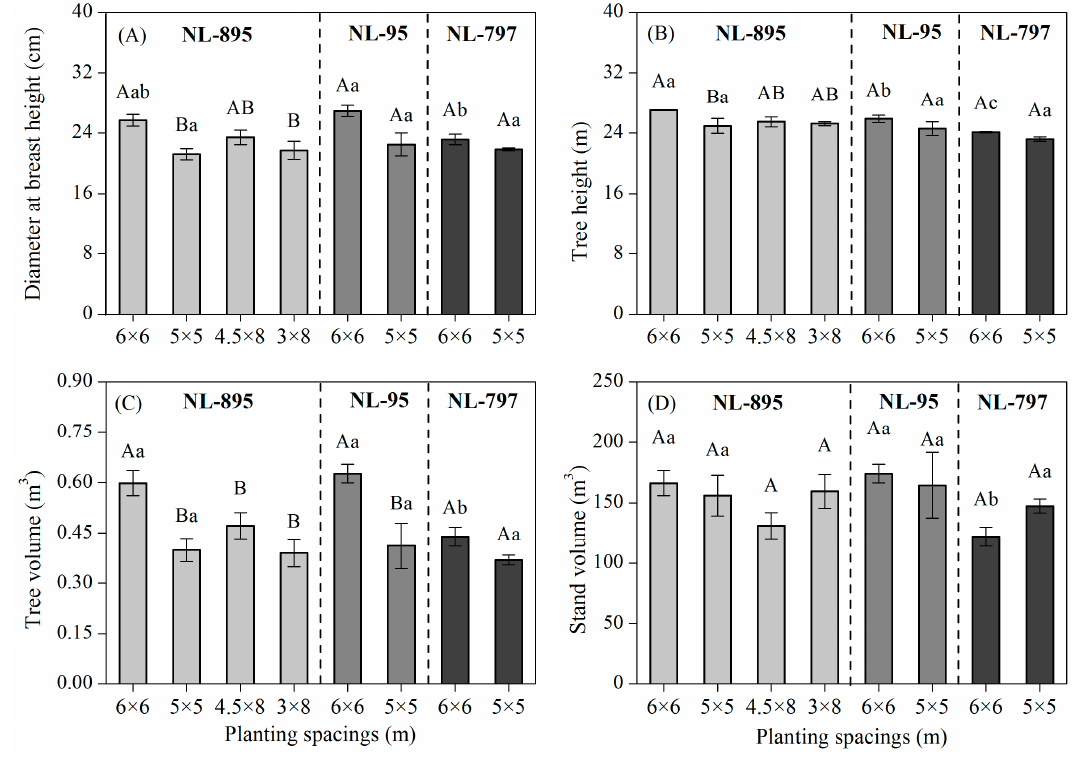
Figure 1. Effects of poplar clones and planting spacings on diameter at breast height ( DBH , A ), tree height ( B ), tree volume ( C ), and stand volume ( D ) in 13-year old poplar plantations. Different capital letters indicate significant differences ( p < 0.05) by Tukey test between planting spacings in each clone, while different small letters indicate significant differences ( p < 0.05) by Tukey test between clones within each planting spacing. The error bars indicate the standard error.